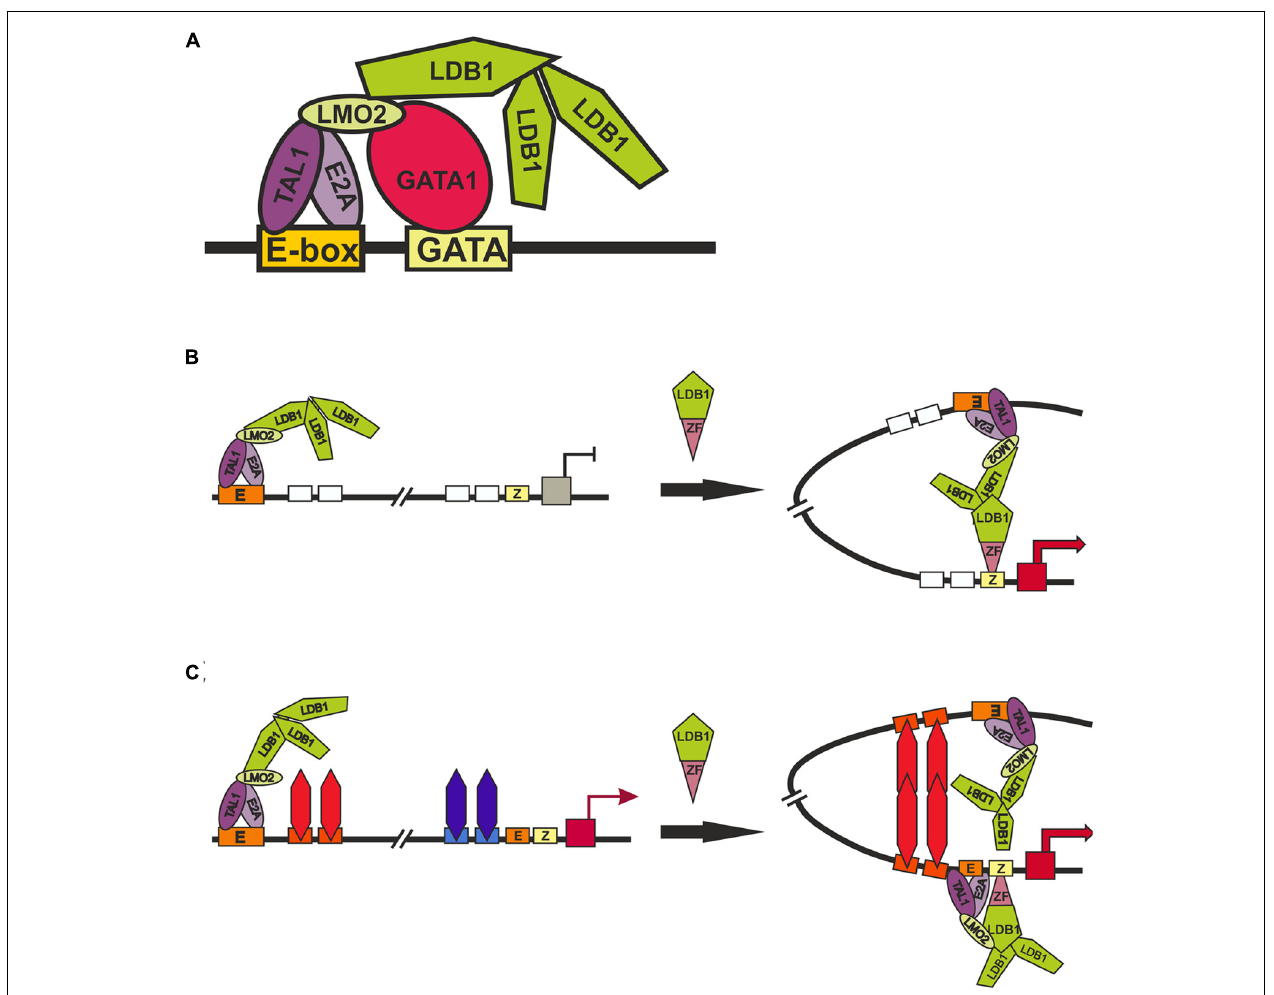
FIGURE 5 | Models of long-distance interaction between LCT and the β -globin promoter. (A) Scheme for the formation of the Ldb1 complex at the E-box and GATA-sites. (B) and (C) two alternative models